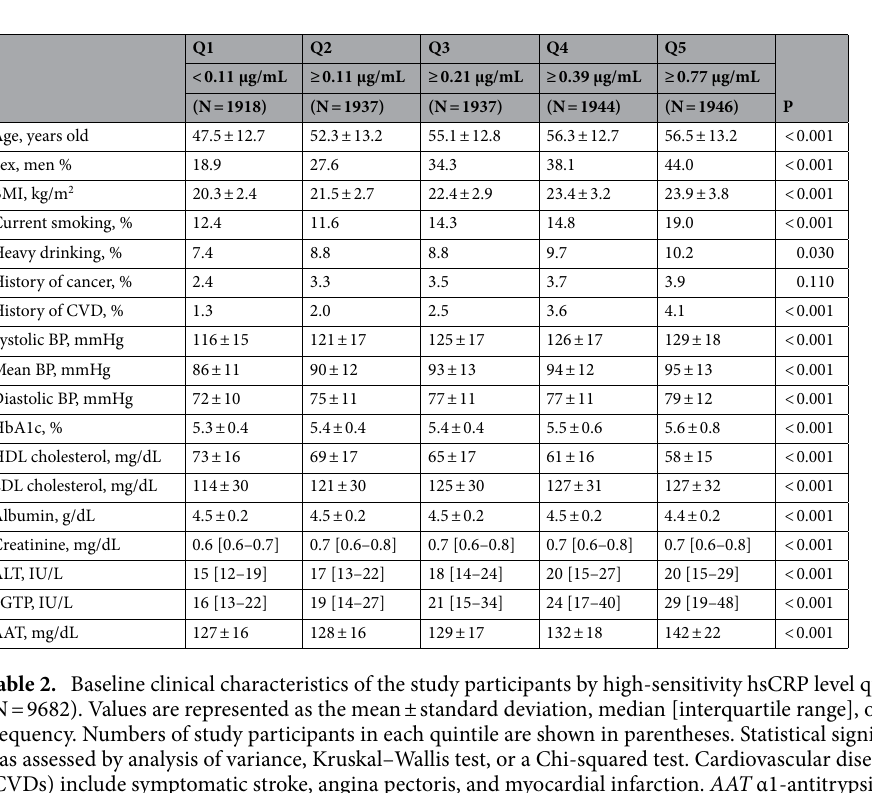
for all-cause death according to the AAT and hsCRP quintiles (log-rank test, all P < 0.001). Table 3 provides the summary statistics of the mortality analysis. The Cox proportional hazard analysis adjusted for possible covariates indicated the highest AAT quintile as an independent risk factor for all-cause death in the analysis of the total study population (Table 4). The analysis, which excluded participants who died within 360 days after baseline investigations (N = 8), produced similar results (AAT Q5, HR = 2.11 (1.40–3.16), P < 0.001). Furthermore, the prognostic significance of AAT remained significant when AAT was included in the Cox model as a continuous variable (per 10 mg/dL, HR = 1.15 (1.10–1.22), P < 0.001). Given the minimum value of AAT in this population (52 mg/dL), none of the participants exhibited severe AAT deficiency, e.g., homozygote of the Glu342Lys dis- function allele of the SERPINA1 gene shows serum AAT levels less than 45 mg/dL 16 . When excluding suspected